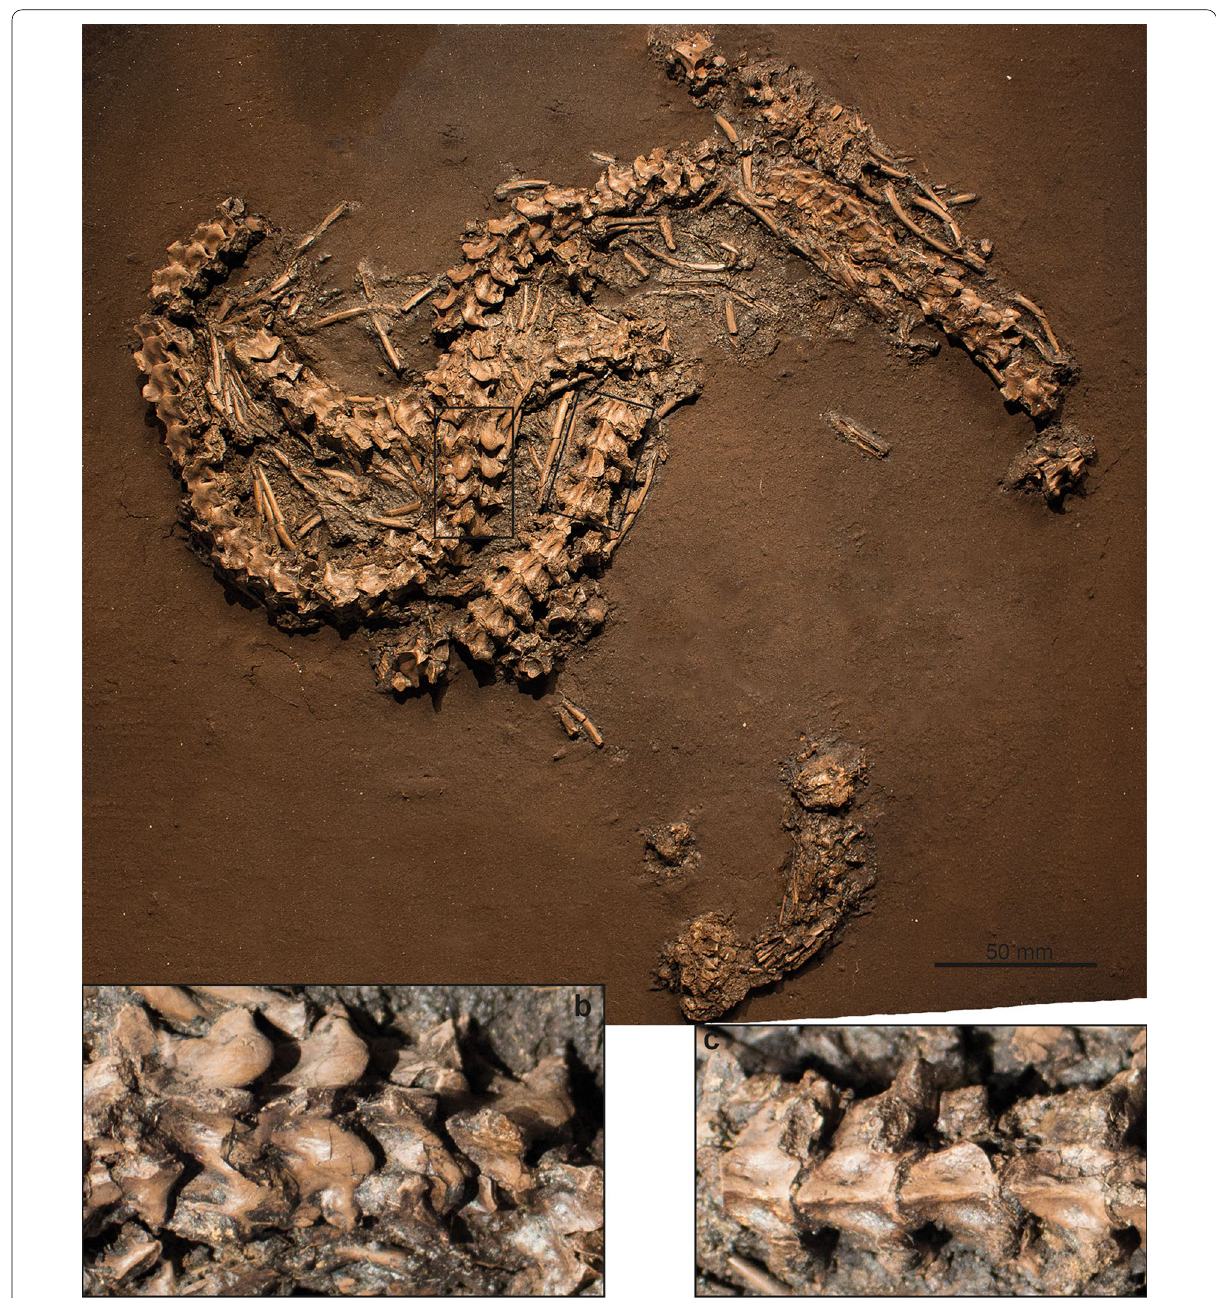
Fig. 63 Eoconstrictor cf. fischeri from quarry XXXVIII, Geiseltal: a large, partial skeleton including series of articulated vertebrae and ribs (GMH XXXVIII-24-1964); b , c close up of several articulated vertebrae of the same